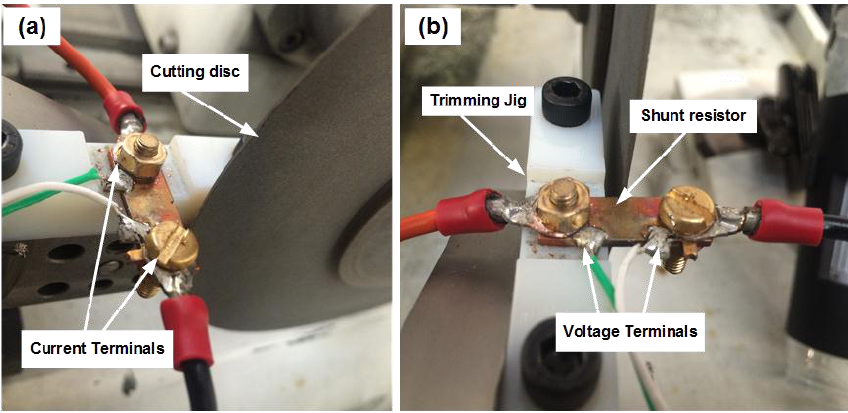
Figure 3. (a) Side and (b) Front views of the concurrent trimming system.